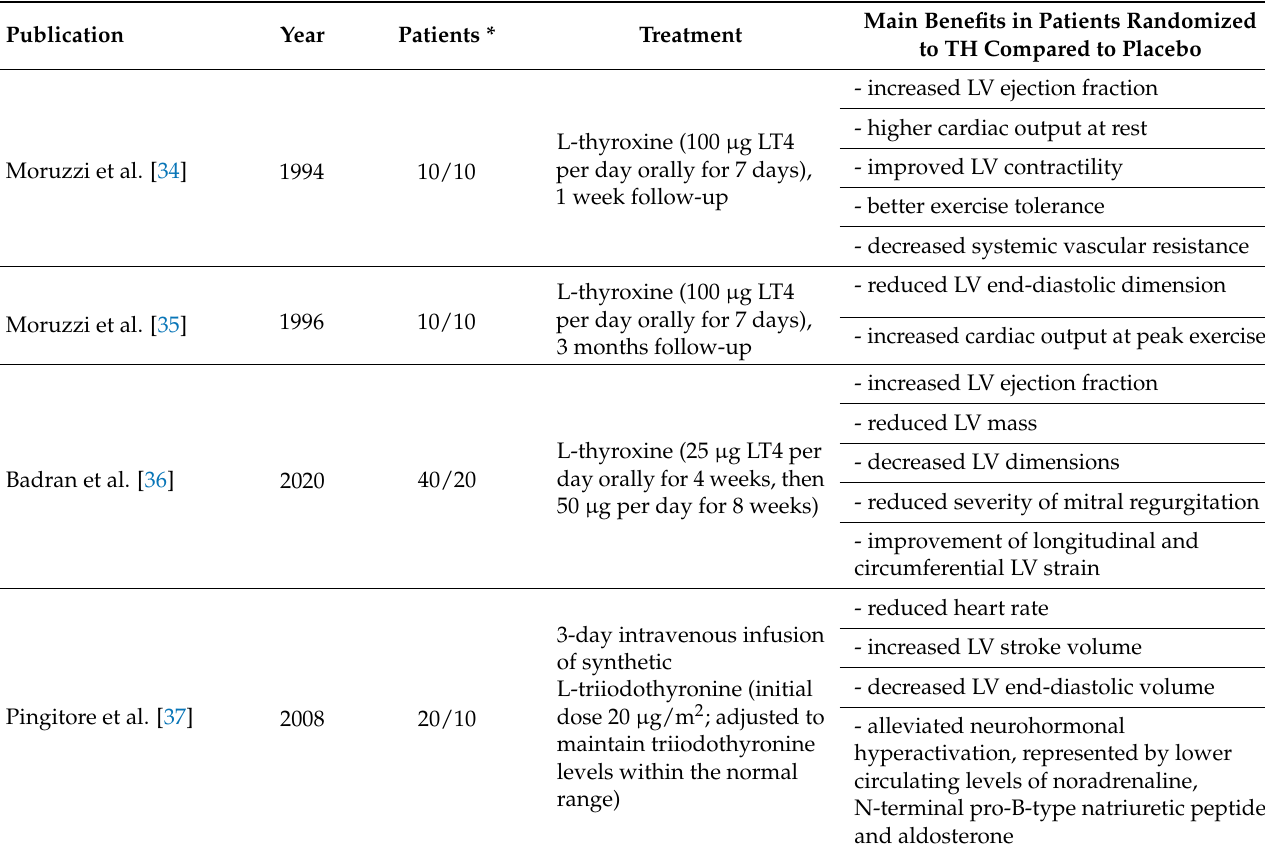
Table 1. Summary of human-randomized, controlled studies on T3/T4 supplementation in DCM [34–37].